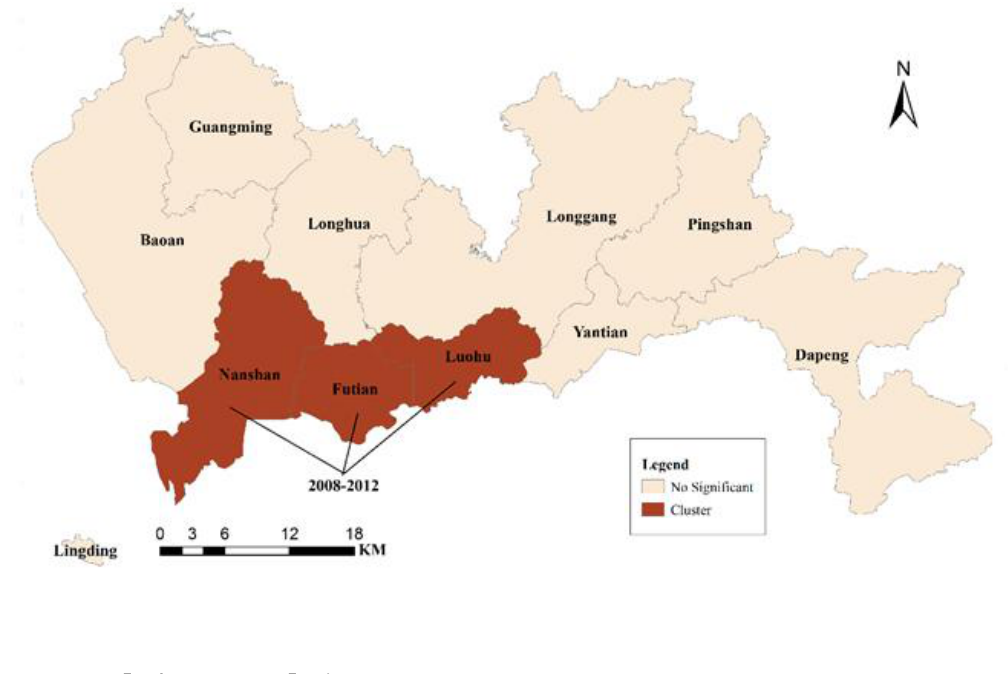
Figure 8. The spatio-temporal clusters of the relative risk in Shenzhen, 2003 to